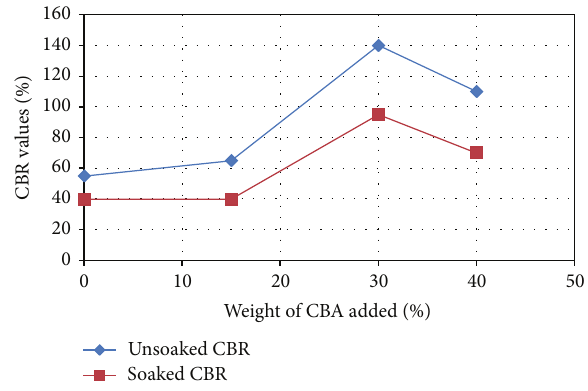
Figure 6: Graph of soaked and unsoaked CBR values with increas- ing CBA content.